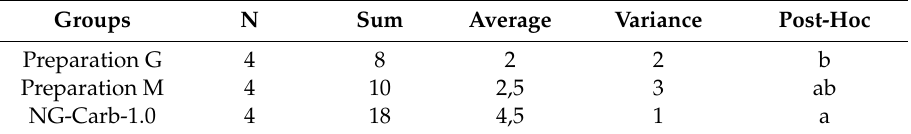
Table 7. Summary statistics from one-way analysis of variance (ANOVA). Groups N Sum Average Variance